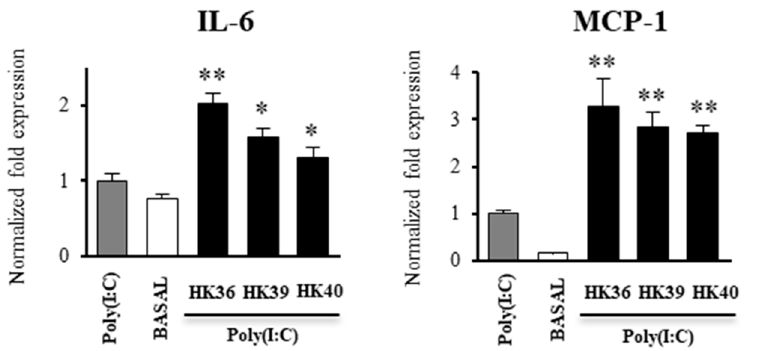
Figure 7. Effect of non-viable Lactobacillus gasseri strains on the expression of inflammatory cytokines genes in porcine alveolar macrophages after the activation of Toll-like receptor 3 (TLR3). Alveolar macrophages were stimulated with non-viable L. gasseri TMT36 (HK36), TMT39 (HK39), or TMT40 (HK40) and then challenged with the TLR3 agonist poly(I:C). The expression of IL-6 and MCP-1 were analyzed by qPCR after 12 hours of TLR3 activation. Non-lactobacilli treated alveolar macrophages challenged with poly(I:C) were used as controls. The results represent data from three independent experiments. Significant differences were observed when compared to polyI(:C)-challenged control porcine alveolar macrophages. * ( p < 0.05), ** ( p < 0.01). In order to further confirm the ability of HK36, HK39 and HK40 on the TLR3 signaling in porcine alveolar macrophages, we next performed western-blot analysis to quantify TRAF3/ β -actin and p-IRF3/IRF3 ratios (Figure 8).